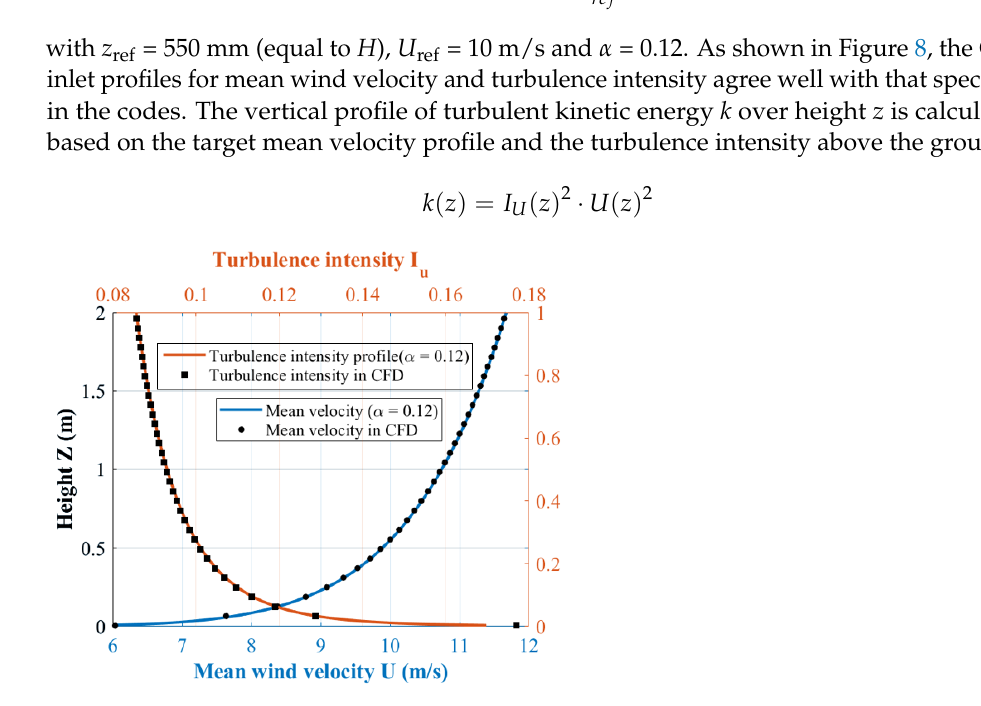
Figure 8. CFD inlet profiles for mean wind velocity and turbulence intensity.